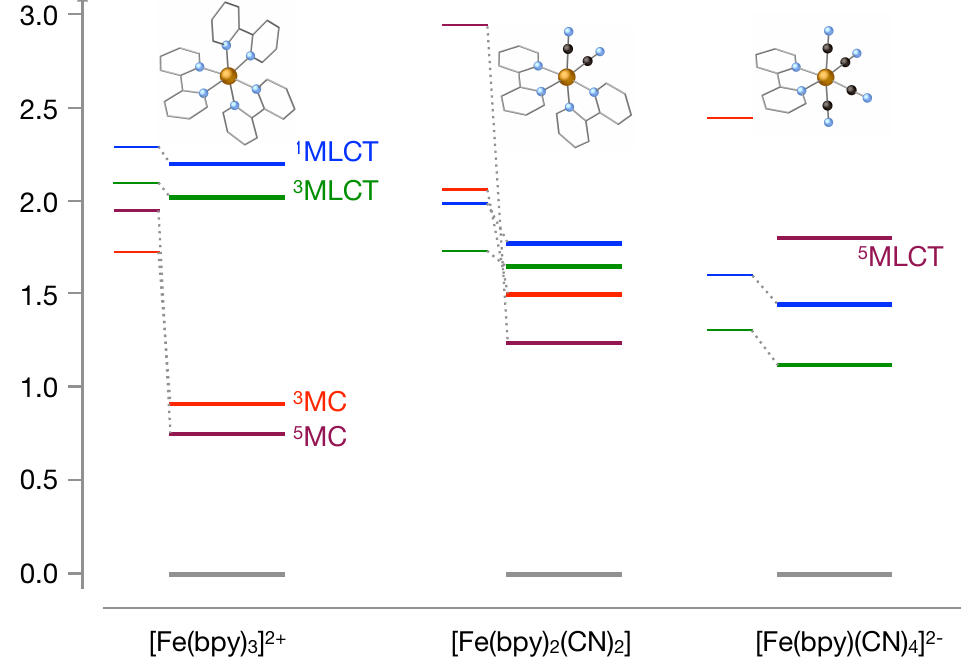
Figure 6. TPSSh/def2-TZVP vertical and adiabatic excitation energies (in eV) for the [Fe(bpy) 3 − x (CN) 2 x ] 2 − 2 x complexes in dimethyl sulfoxide ( x = 0,2) and methanol ( x = 1). The thin lines correspond to vertical excitation energies and the thicker lines to adiabatic